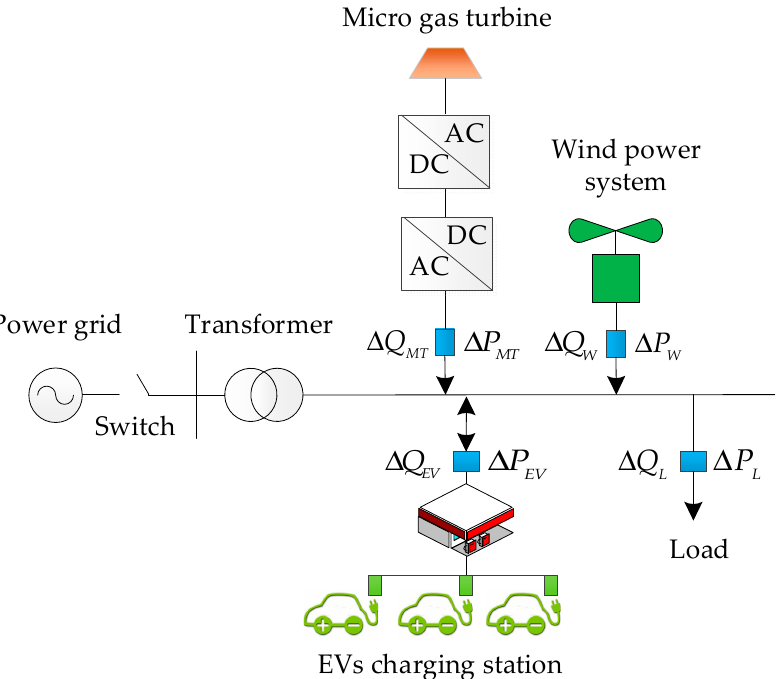
Figure 4. Structure of the islanded microgrid.